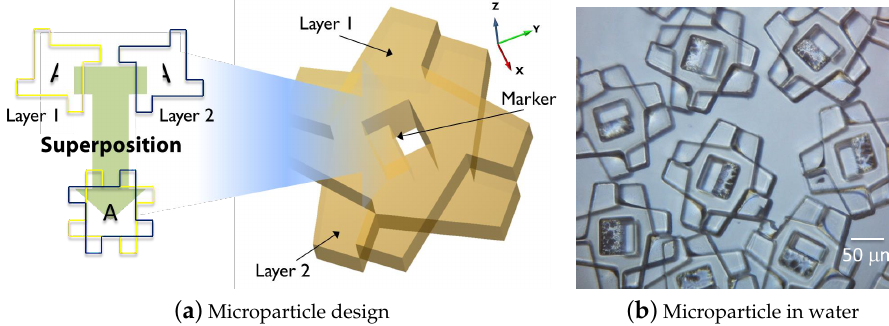
Figure 7. ( a ) 3D design of the microparticles for fluidic self-assembly (SA); ( b ) microfabricated SU-8 microparticles in water